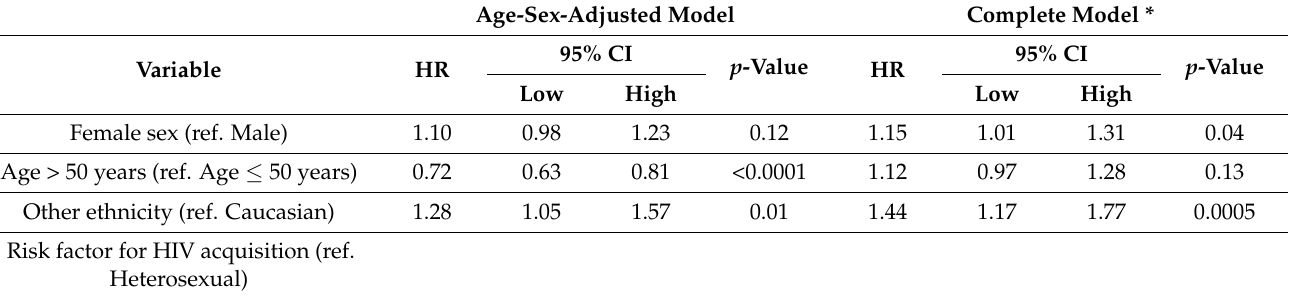
Figure 1. Percentage of discontinuation causes in patients enrolled in the SCOLTA project cohorts during the first, second and third year of treatment. Table 5. Hazard ratios (HR) and 95% confidence interval (CI) for any cause treatment interruption in 3656 antiretroviral experienced subjects during the entire